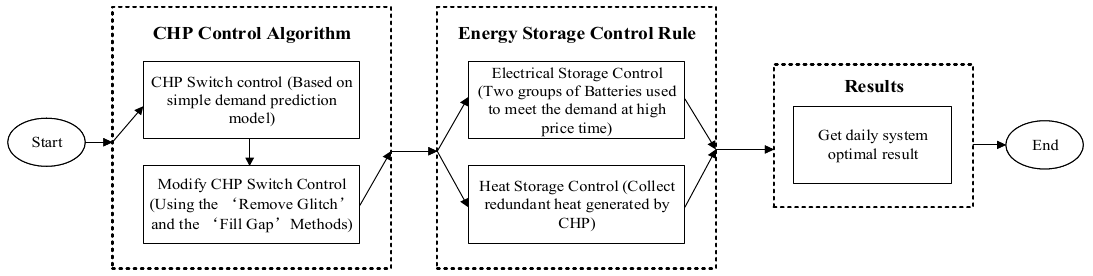
Figure 1. Energy Hub optimisation algorithm proposed in this paper.